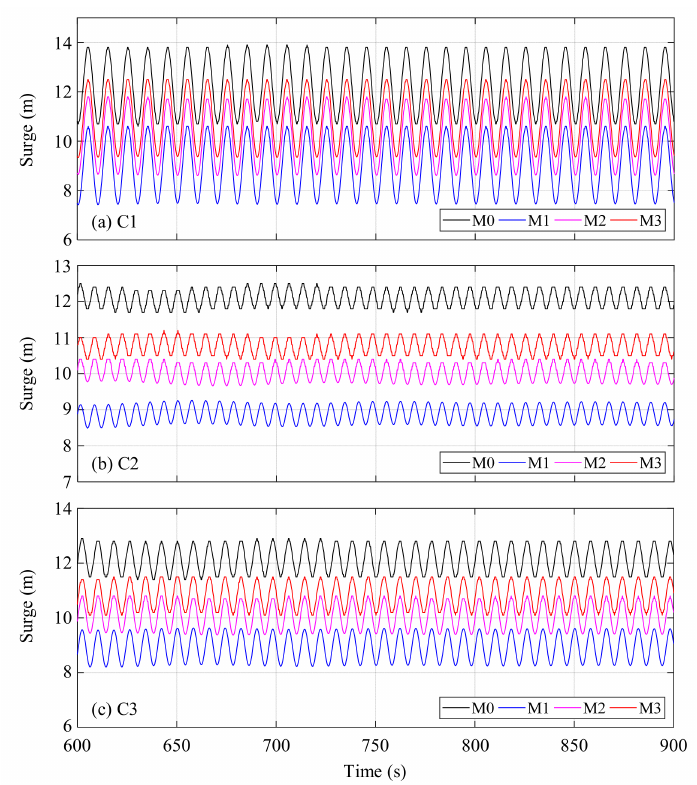
Figure 6. Wind turbine surge movement time series with M0–3 when under: ( a ) C1; ( b ) C2; ( c )